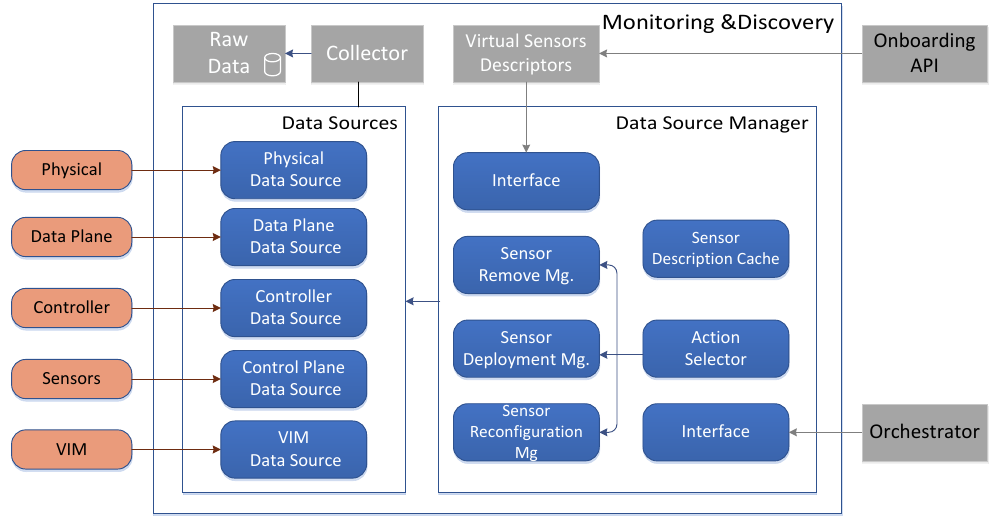
Figure 15. Data Source Manager: Sensor Operations.